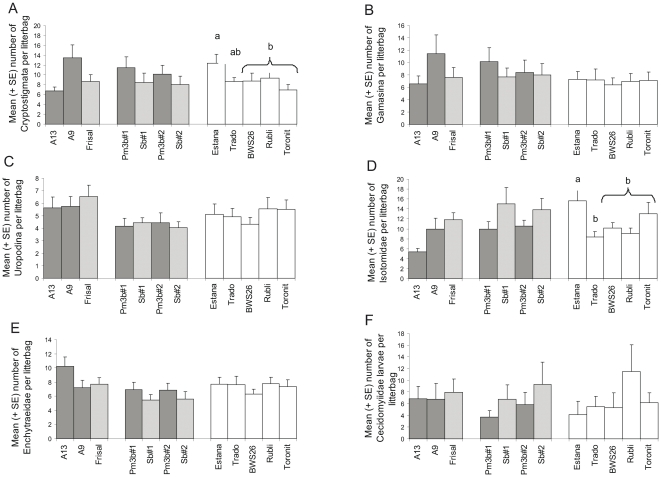
Mean (+ SE) number of individuals of the six most frequent taxa per litterbag (2009 experiment).GM group (N = 60 per variety): GM varieties are displayed dark grey and non-GM varieties bright grey. Conventional cereals (N = 60 per variety) are displayed white. Taxonomic groups are A Cryptostigmata, B Gamasina, C Uropodina, D Isotomidae, E Enchytraeidae and F Cecidomyiidae larvae. Different letters above the columns indicate significant differences (Tukey HSD test, P<0.05). Only significant differences are labeled.